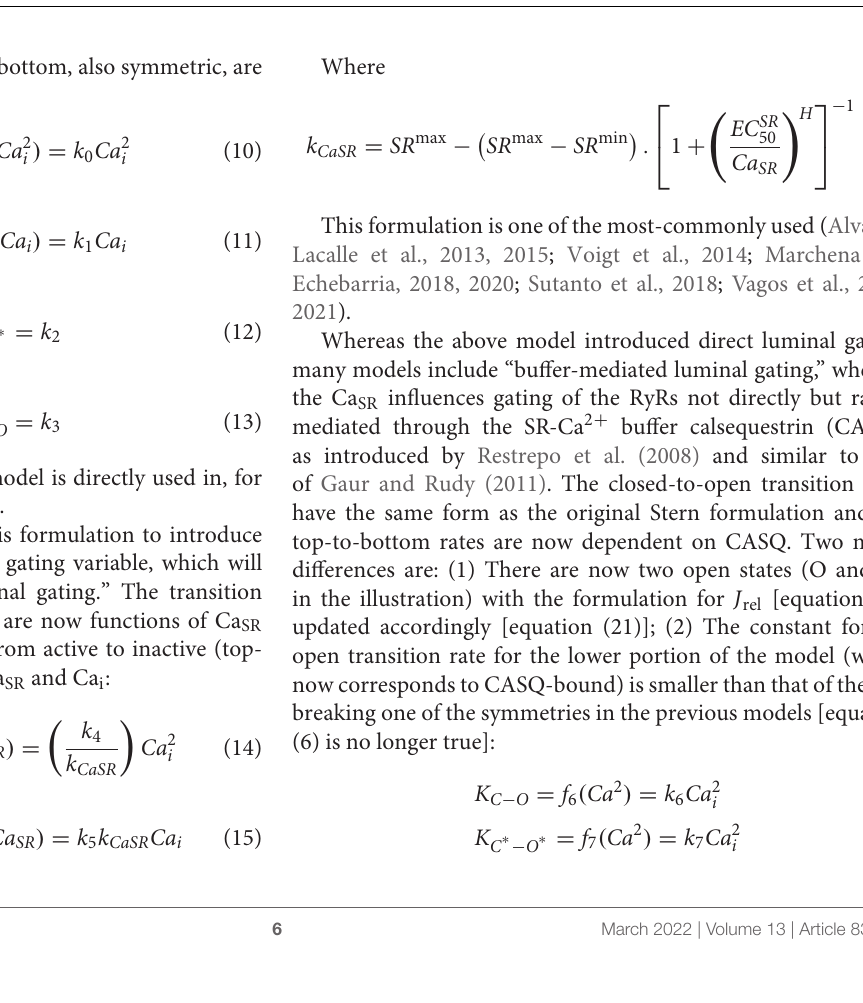
FIGURE 3 | Illustration of RyR Markov-chain models. The four-state, two-state and three-state models are illustrated with the different features highlighted and a selection of publications in which they are used listed. Block arrows indicate model inheritance.